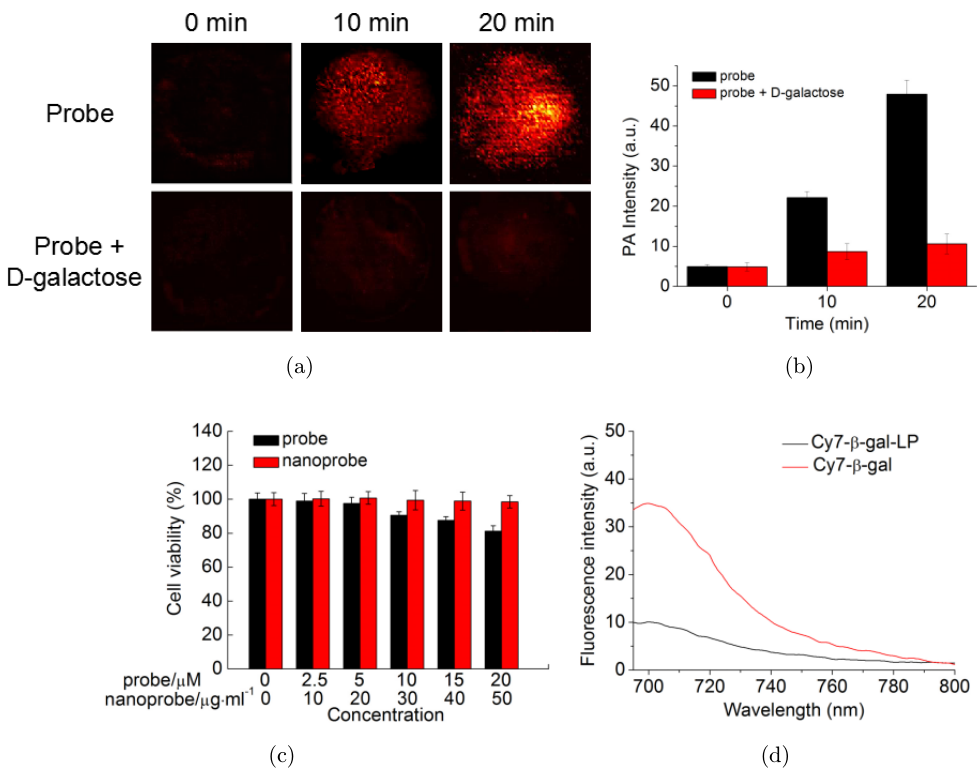
Fig. 3. The PA detection of Cy7- (cid:1) -gal on HepG2 cells. (a) PA images of HepG2 cell pellets after incubated with Cy7- (cid:1) -gal (5 (cid:2) M) in the presence (absence) of (cid:1) -gal inhibitor ( D -galactose). (b) Quanti¯cation of the PA intensity at 680 nm for HepG2 cell pellets incubated with Cy7- (cid:1) -gal (5 (cid:2) M) in the presence (absence) of (cid:1) -gal inhibitor ( D -galactose). (c) Cell viability of the HepG2 cells treated with probe or nanoprobe at various concentrations. (d) Fluorescence spectra of Cy7- (cid:1) -gal and Cy7- (cid:1) -gal-LP.